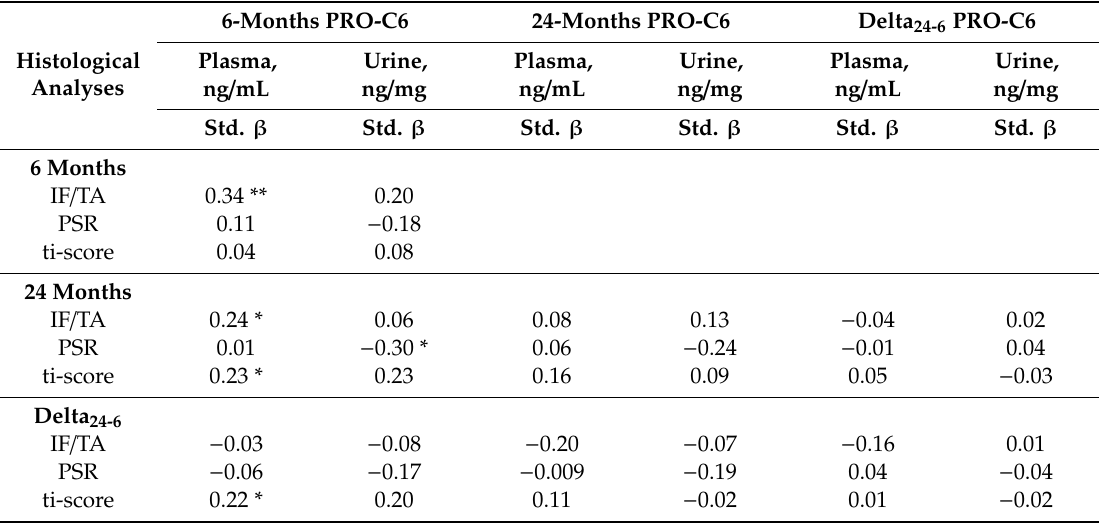
Table 4. Association of histological analyses with plasma and urine